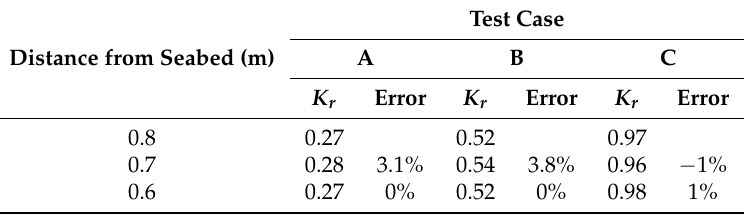
Table 7. Reflection coefficients for probes of varying vertical positions in deep water (1m) simulations.